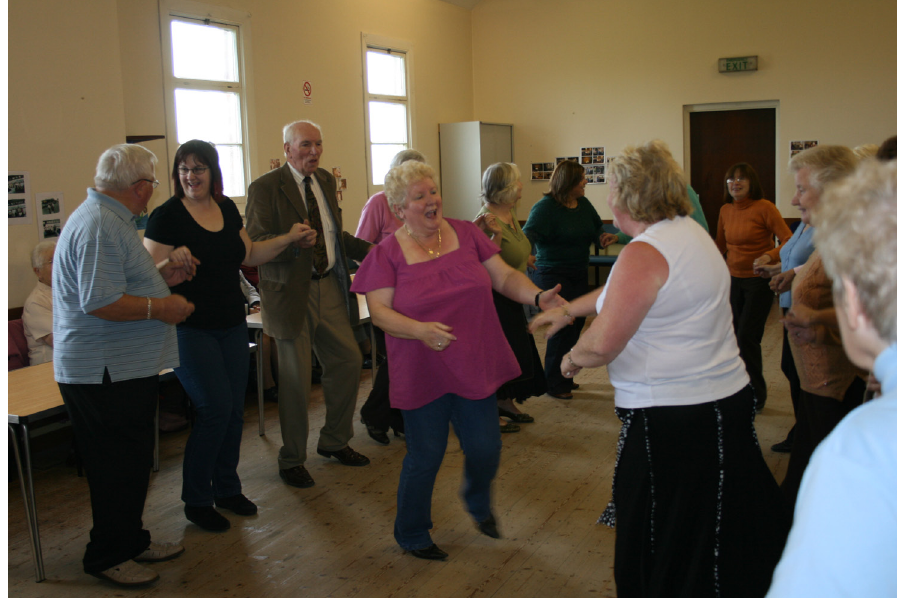
Figure 1 ‘Reminiscence Through Dance’